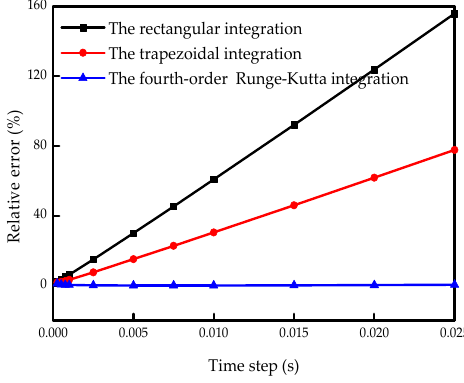
Figure 6. Relative damping errors by three integration methods.